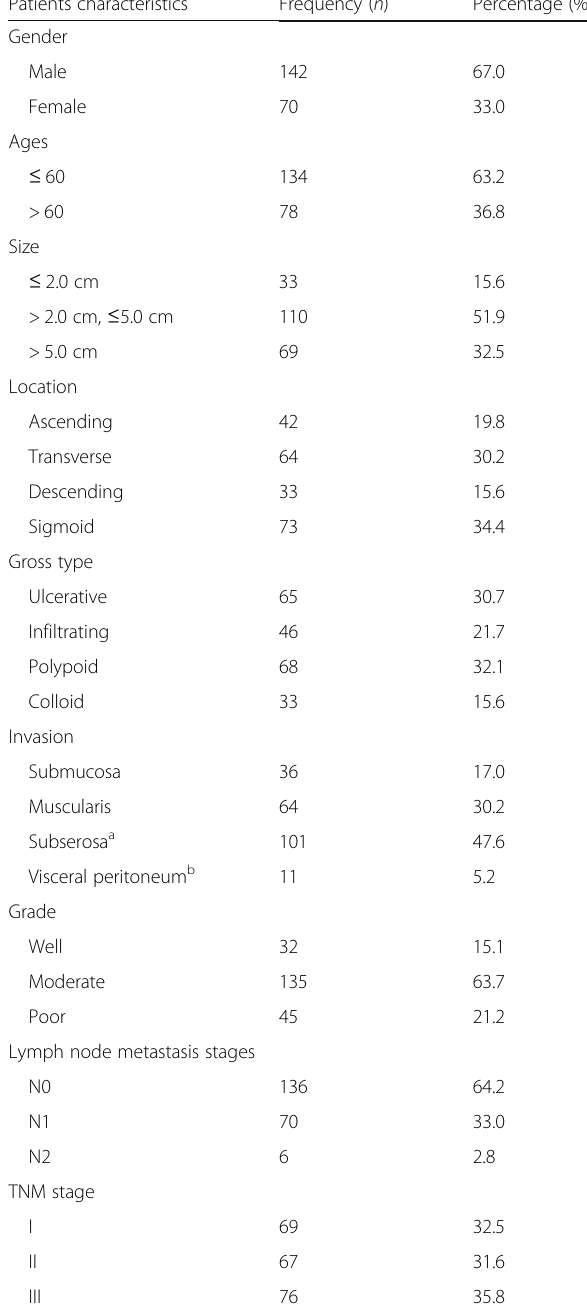
Table 1 Patients characteristics Patients